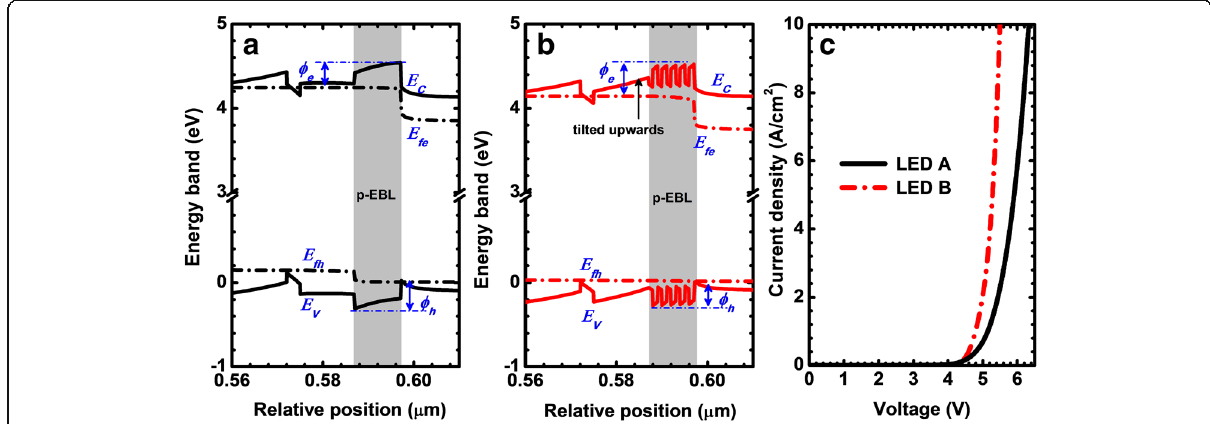
Fig. 5 Numerically computed energy band profiles in the vicinity of a bulk AlGaN-based p-EBL for LED A, b superlattice p-EBL for LED B, and c measured current density in terms of the applied bias for LEDs A and B. Data for a and b are calculated at the current density of 50 A/cm 2 . E C , E V , Ø e , and Ø h denote the conduction band, the valence band, and the effective barrier heights for conduction band and valence band,